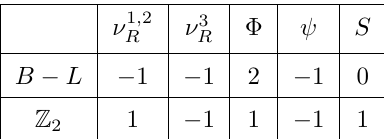
Table 1 . Quantum numbers of the BSM particles. All particles listed here are singlets under the SM gauge